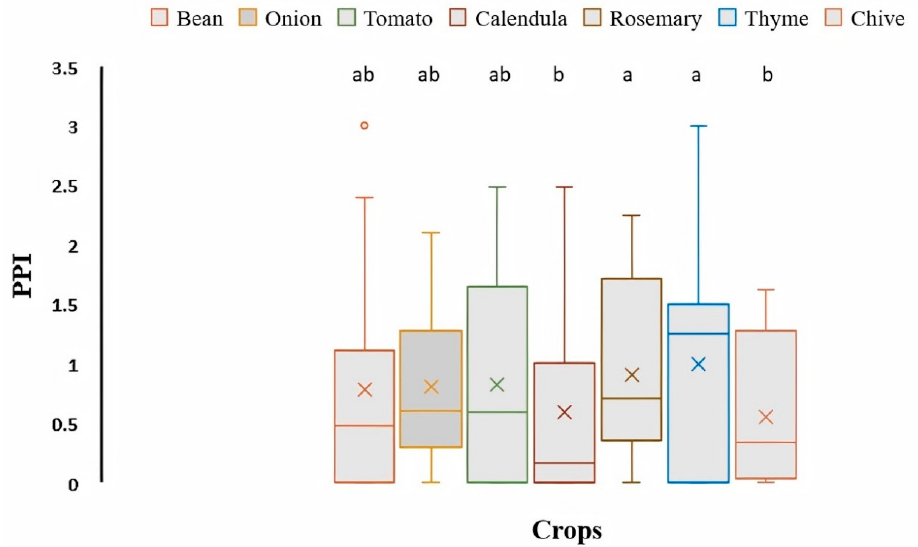
Figure 6. Plant parasitic index (PPI) of organic vegetable and medicinal crops surveyed in Southern Morocco. Letters represent homogeneous groups based on protected least significant difference test (LSD) for each variable at ( P < 0.05) ( n = 5). The middle boxplot line represents the median (Q2) while the (x) spots represent the mean. Quartiles Q1 and Q3 were calculated accordingly for each treatment. Error lines represent the maximum and minimum values, respectively.